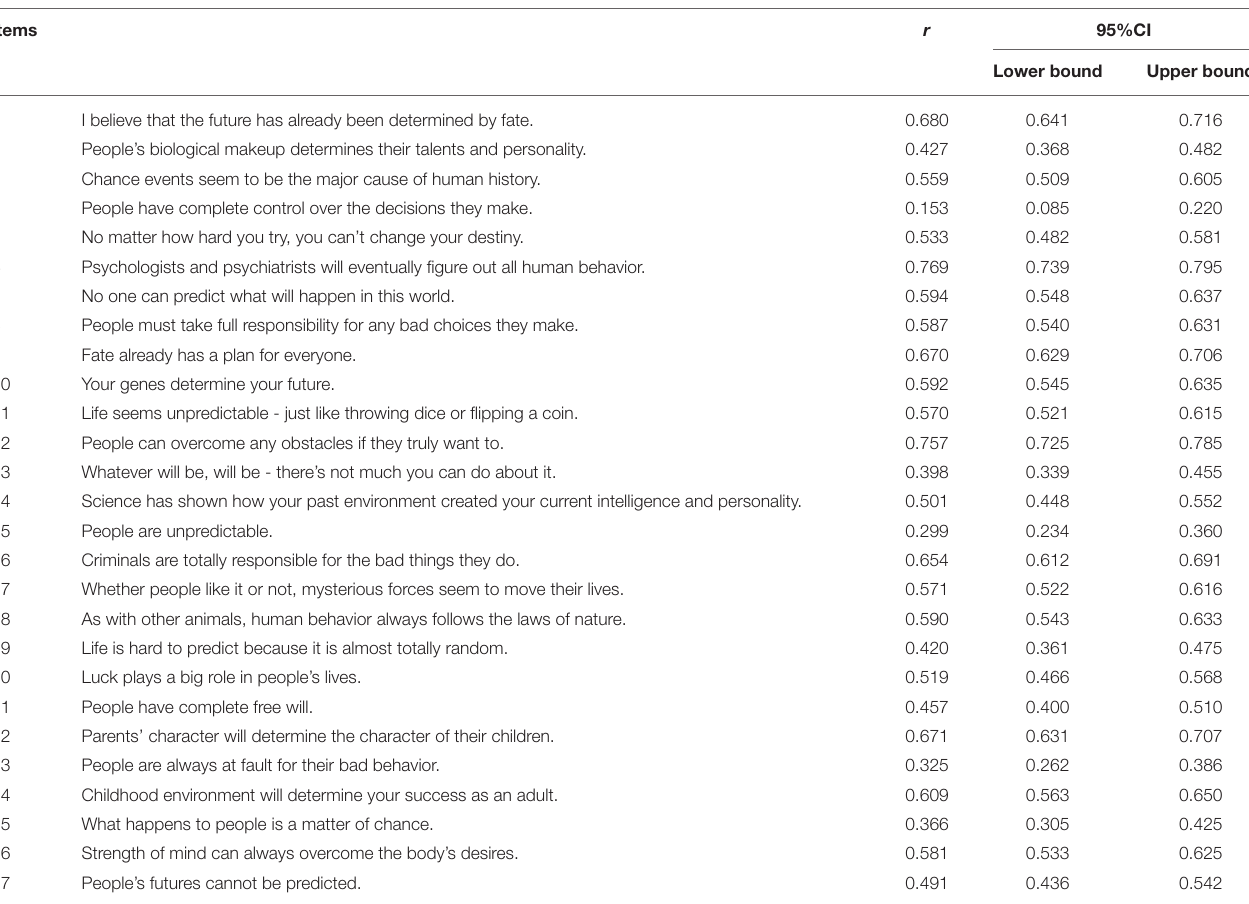
TABLE 3 | Correlation coefficients between item pairs translated from the same items. Items r 95%CI